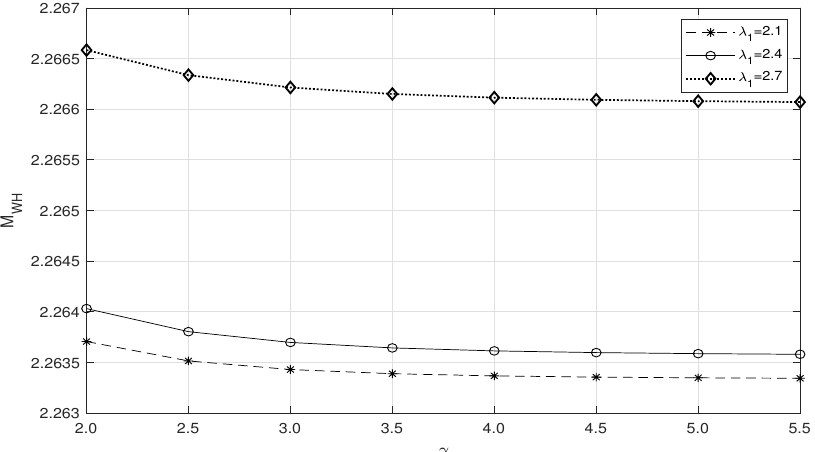
Figure 12. Mean number of customers in the waiting hall on λ 1 vs. γ